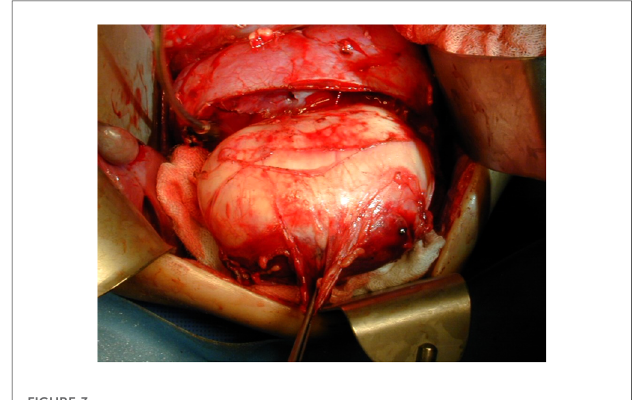
FIGURE 3 Separating the normal renal parenchyma from the tumor, using an enucleation approach, to ensure maximal parenchyma